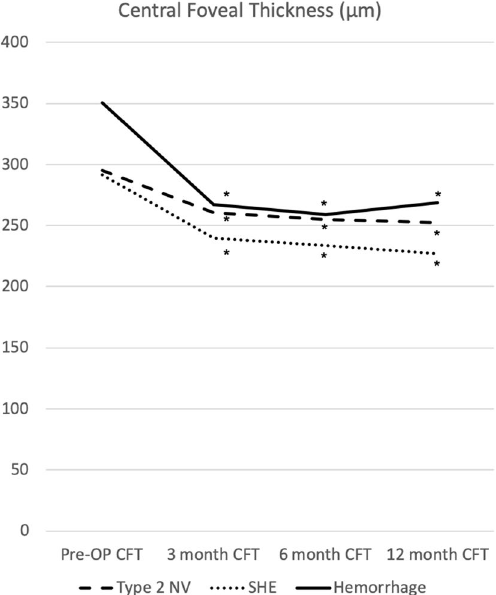
Figure 4. Central foveal thickness according to different SHRM types after 1 year of treatment. *p < 0.05 compared with baseline visual acuity. SHRM subretinal hyperreflective material, OP operation, CFT central foveal thickness, NV neovascularization, SHE subretinal hyperreflective